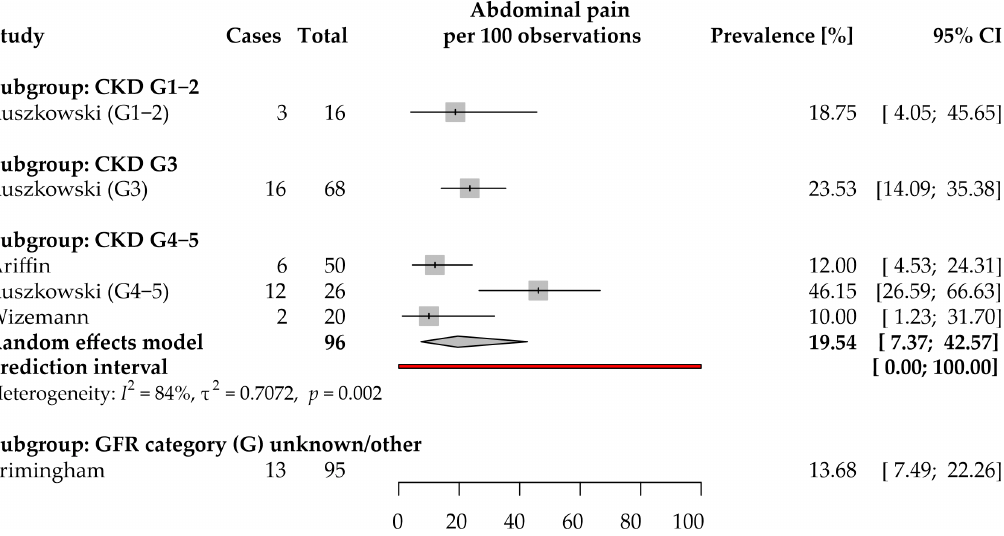
Figure 6. Forest plot with pooled point prevalence estimates for self ‐ reported abdominal pain in chronic kidney disease by stages.